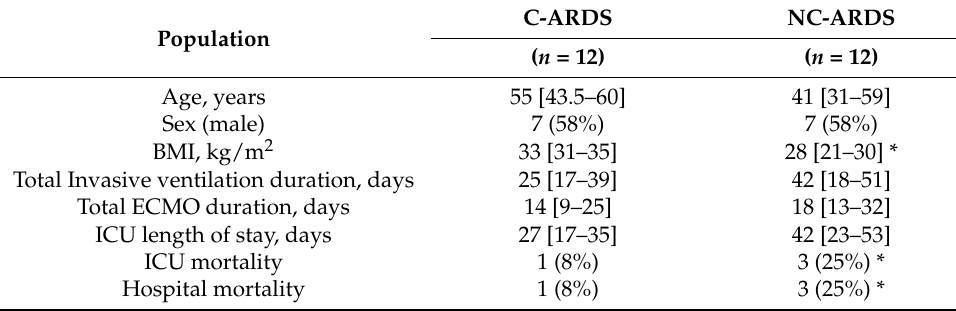
Table 1. Demographics, clinical characteristics, and outcome.